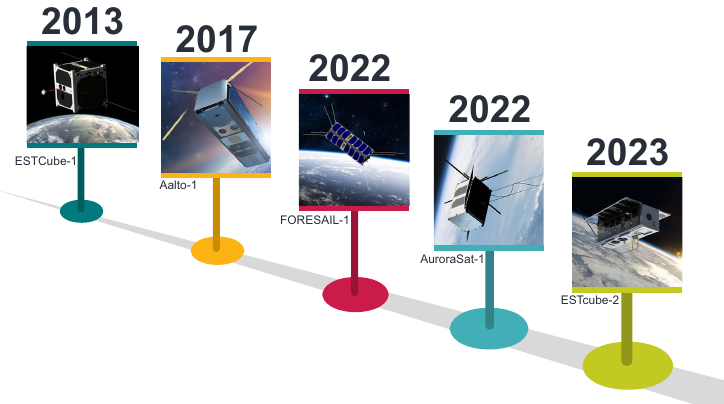
Figure 2. Timeline of the space missions that uses PB